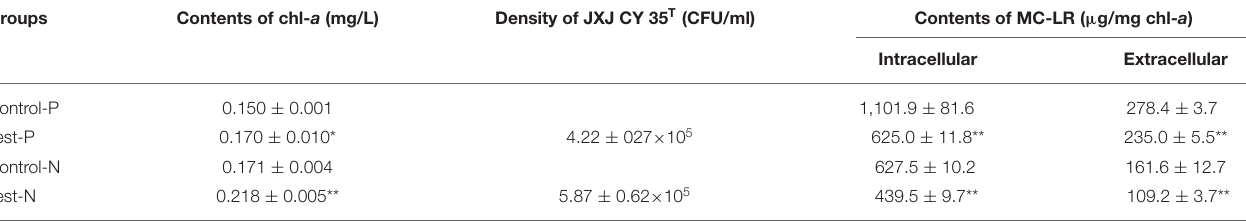
TABLE 3 | Influences of no available N and P on Maf and JXJ CY 35 T of cocultures.